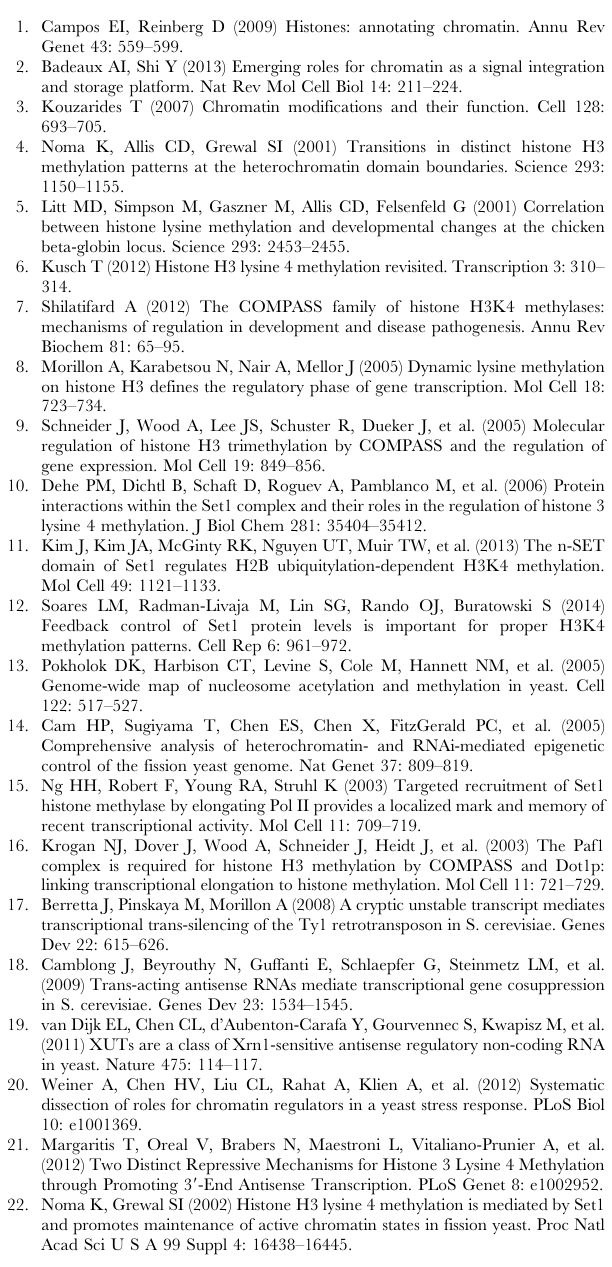
Figure S6 Loss of set1 results in increased H3K9 acetylation at pericentromeric repeats. (A) Enrichment of H3K9 methylation (H3K9me2) (Abcam, ab1220) and (B) H3K9 acetylation (H3K9ac) (Millipore, 07-352) was determined by chromatin immunoprecip- itation (ChIP) followed by quantitative PCR (qPCR) using primers corresponding to the pericentromeric repeat dg region. ChIP fold enrichment of H3K9me2 and H3K9ac at the dg repeat was determined relative to the corresponding enrichment at (A) the act1 promoter and (B) the 3 9 region of act1 , respectively (s.d., error bars; n = 3